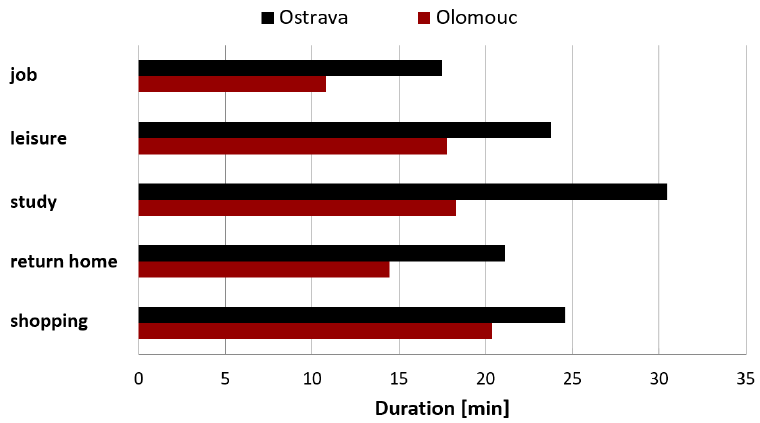
Figure 8. Average duration of routes (in minutes) according to the purpose in Olomouc and Ostrava.